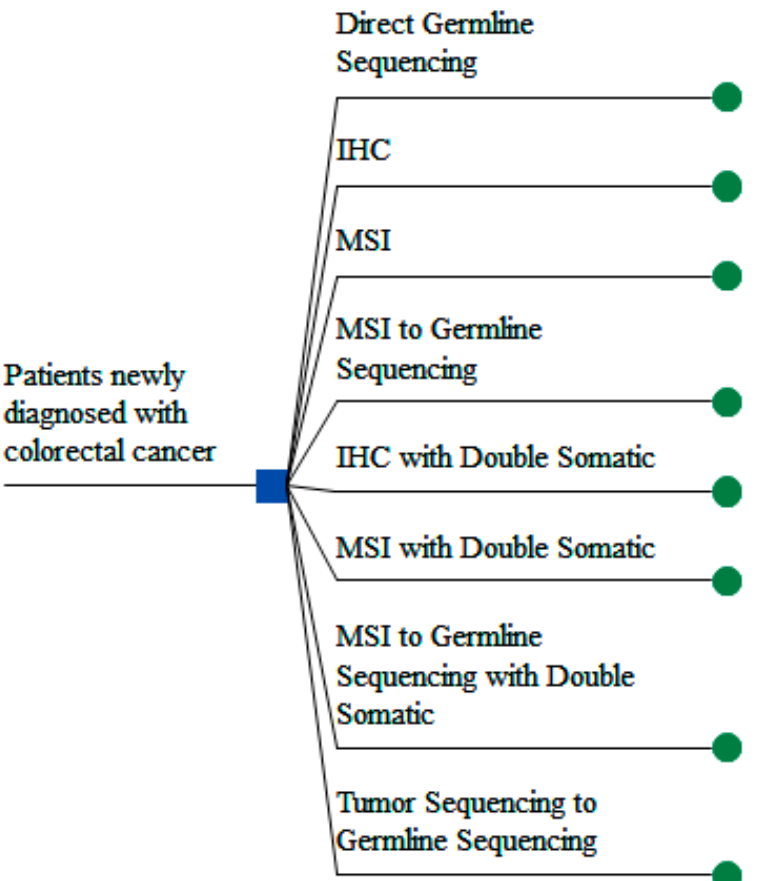
Figure 1. Lynch syndrome (LS) screening protocols. Note: IHC, immunohistochemistry; MSI, microsatellite instability. Germline sequencing refers to next generation sequencing (NGS) panel including MMR genes in all protocols.